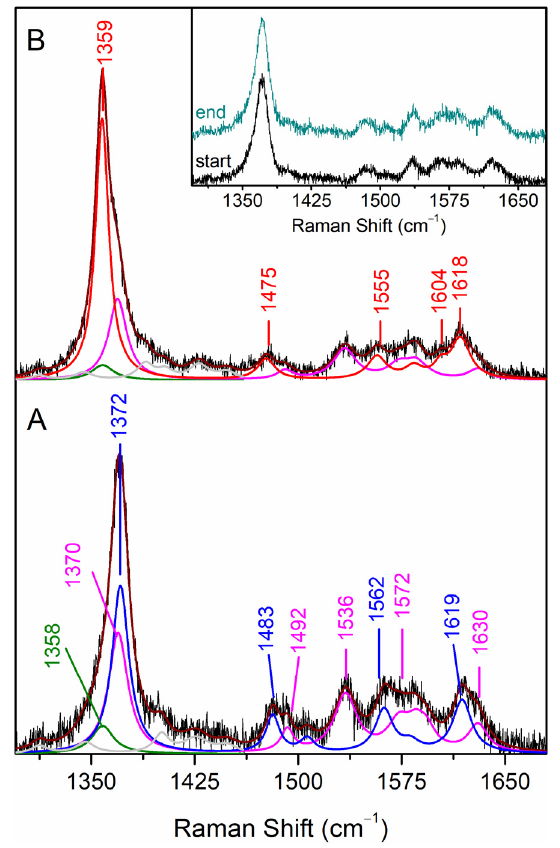
Figure 3. SERR spectra of CboDyP immobilised on Ag electrodes coated with 1-undecanethiol: 11- amino-1-undecanethiol hydrochloride SAM (M:M, 2:1) recorded at potentials poised at ( A ) +250 mV and ( B ) − 200 mV. The component spectra represent the overall fit (dark red), ferric 6cHS (blue), redox-inactive ferric 5cHS (magenta), ferrous 6cHS (red) and redox-inactive ferrous (green) species and non-assigned bands (grey). Inset: SERR spectra acquired at the electrode potential poised of +250 mV before and after the electrode was poised at four different potentials. All spectra were obtained with 405 nm excitation at pH 7 and 21 °C.